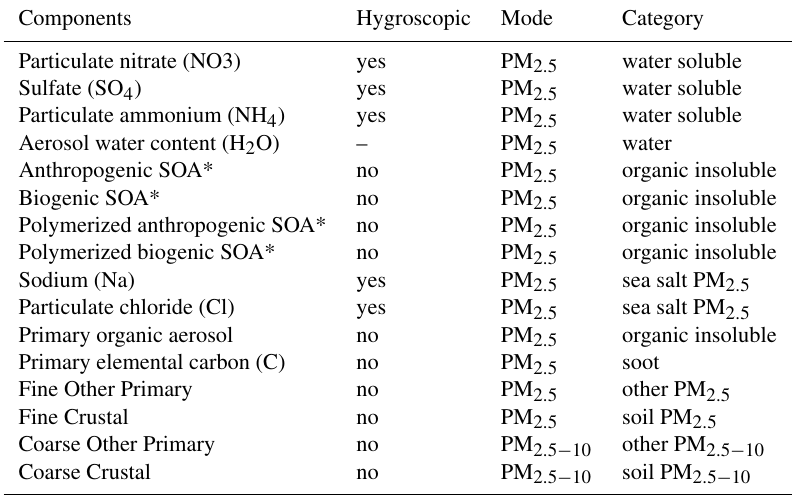
Table 1. CAMx aerosol component synopsis. Fine Other Primary mainly consisted of the PM 2 . 5 aerosols that are treated as inert by the model. It also contains a small part of the PM 2 . 5 sea salt that cannot be treated as particulate chloride or as sodium. The Coarse Other Primary component includes all the PM 2 . 5 − 10 aerosols that are not crustal (nitrate, sulfate, ammoniac, black carbon and primary organic aerosols) as well as the PM 2 . 5 − 10 sea salt and all the other particles that are considered inert by the